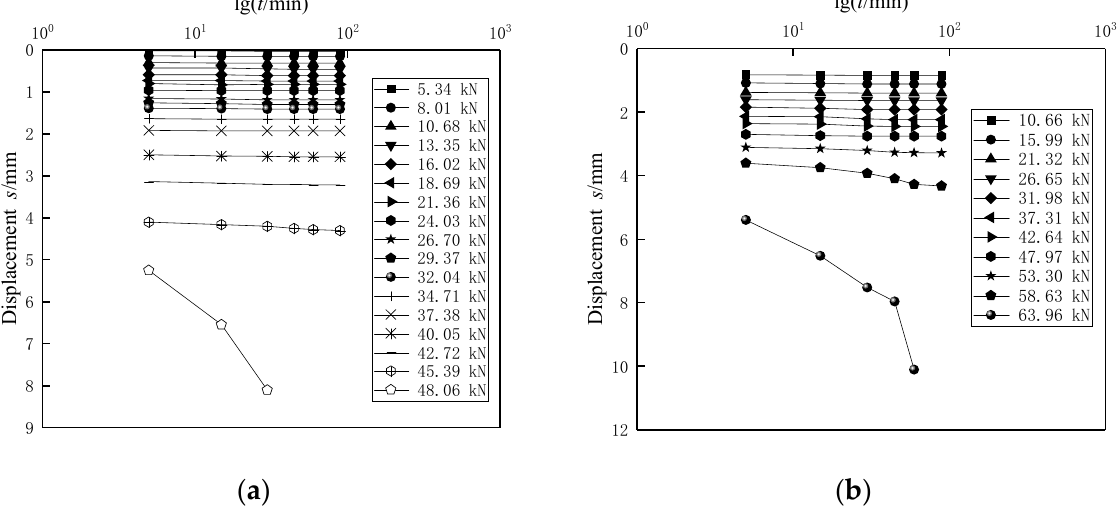
Figure 5. s-lgt curves of test pile: ( a ) the pile-end soilless compressive pile and ( b ) the conventional compressive pile.